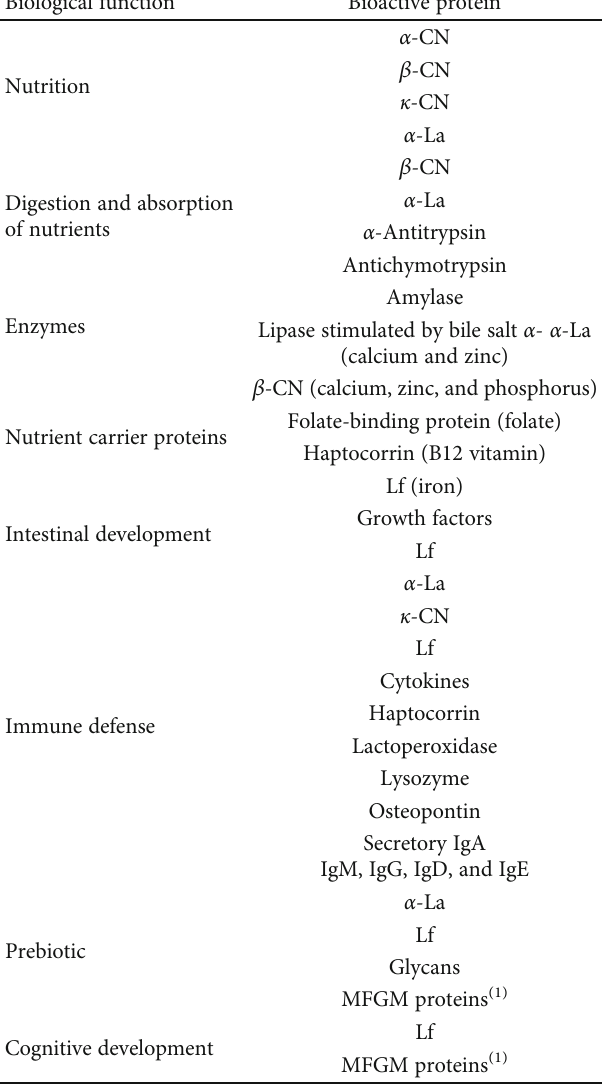
Table 1: Human milk proteins and their biological functions. Biological